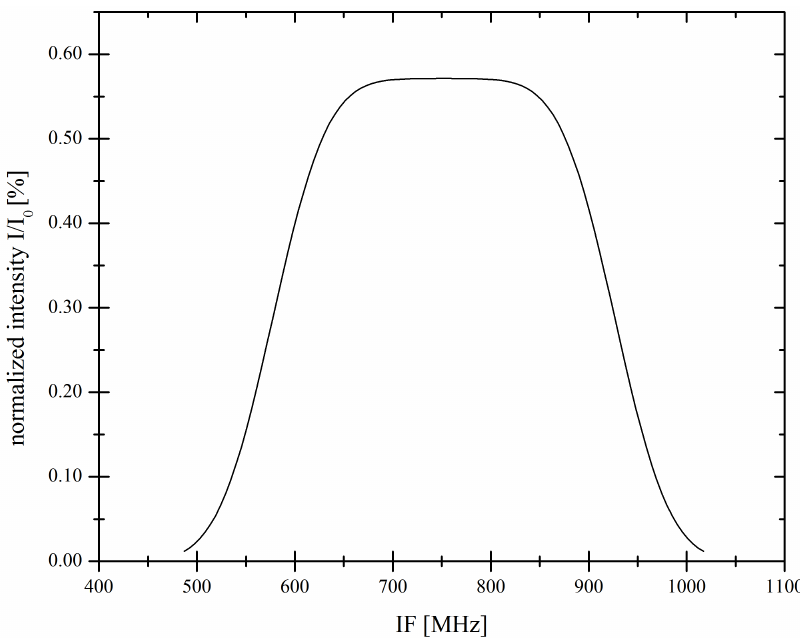
Figure 3. Line shape of the heterodyne signal for a triangular wave modulation form (TWM) with ∆ ν = 3.37 FWHM . For a large modulation bandwidth, ∆ ν , the line disperses and 0 forms a plateau around its center frequency.